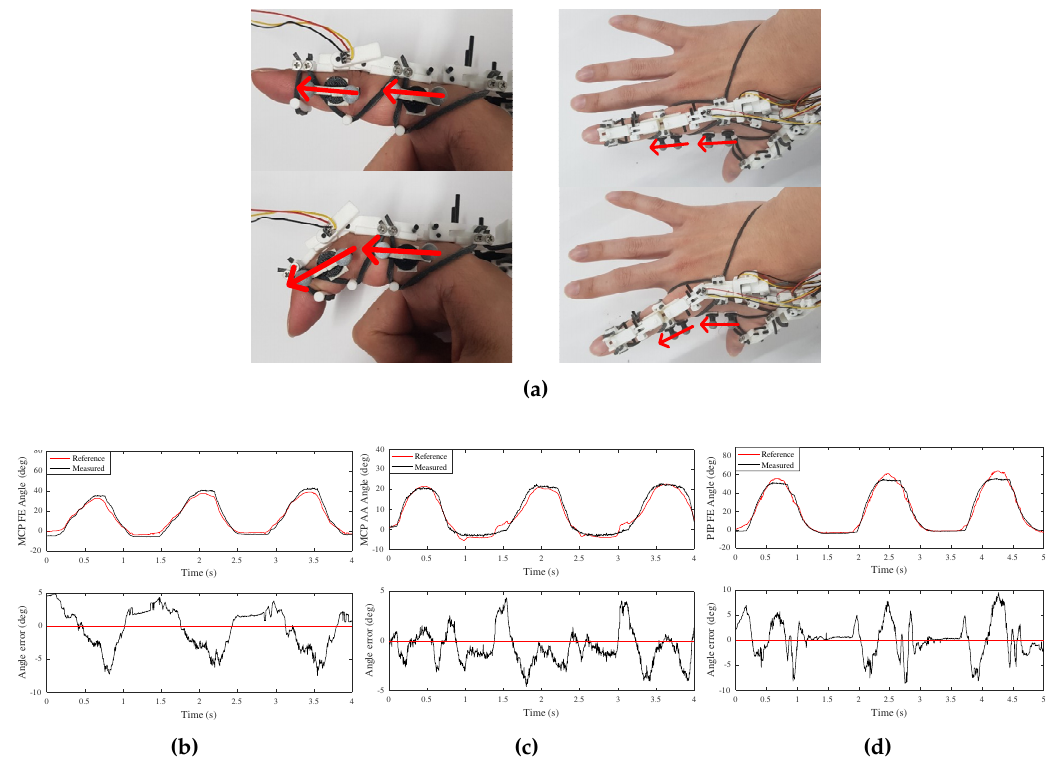
Figure 11. Experimental verification of index finger motion; ( a ) Experimental setup; ( b ) F/E motion of MCP joint; ( c ) Ab/Ad motion of MCP joint; ( d ) F/E motion of PIP